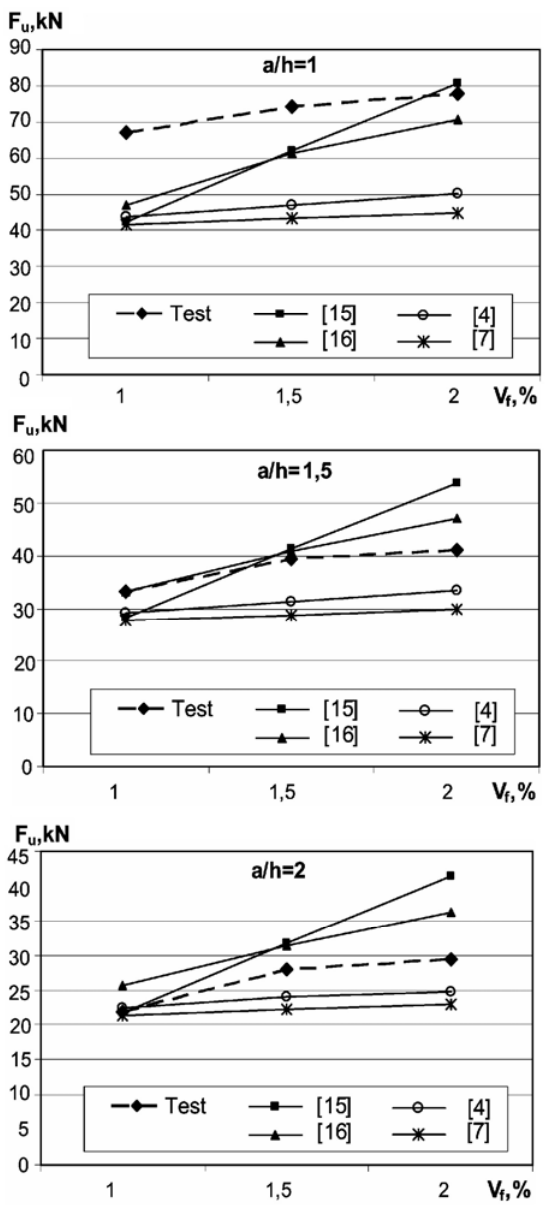
Fig 8. Influence of fibre volume on load capacity at vari-